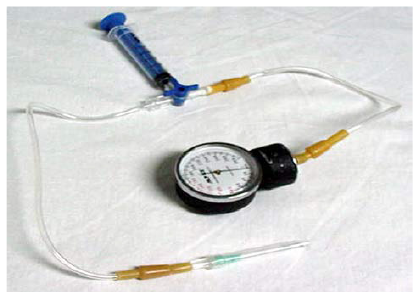
Figure 3. Stryker needle with a manometer for measuring intra- compartmental